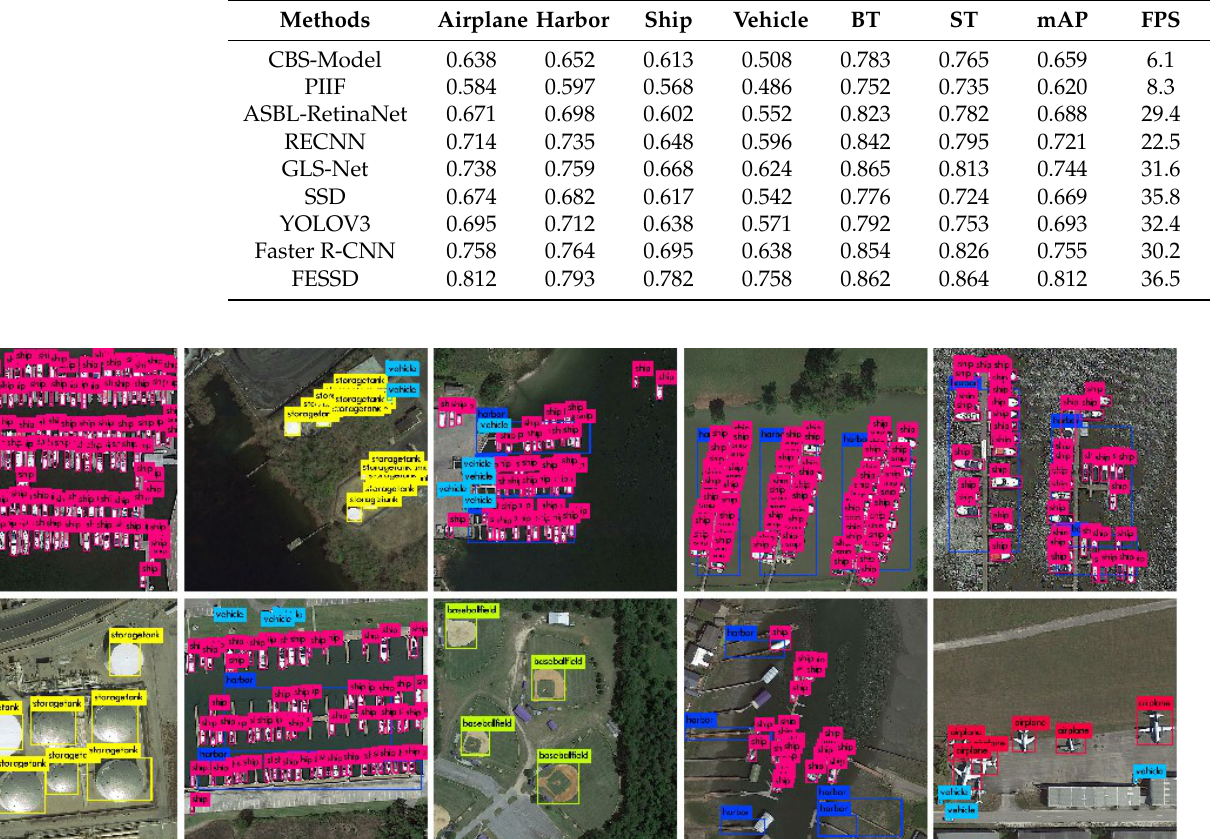
Table 4. The performance comparison of different methods on the DIOR dataset.